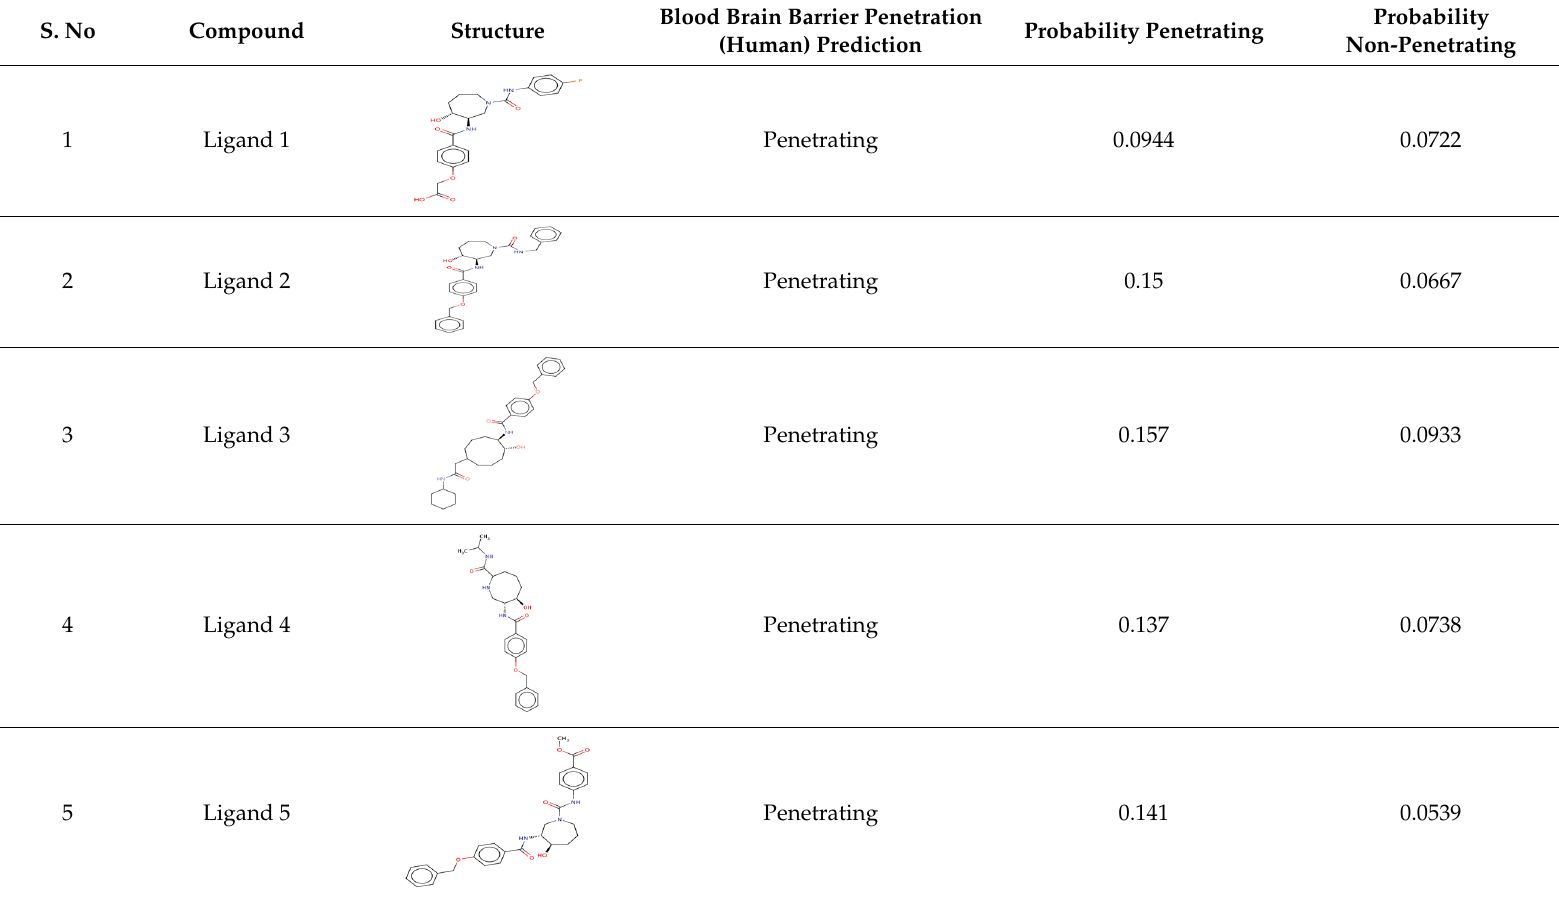
Table 5. Blood brain barrier (BBB) penetration analysis with a lazar tool prediction for top five therapeutic ligands involved in p-tau inhibition. S. No